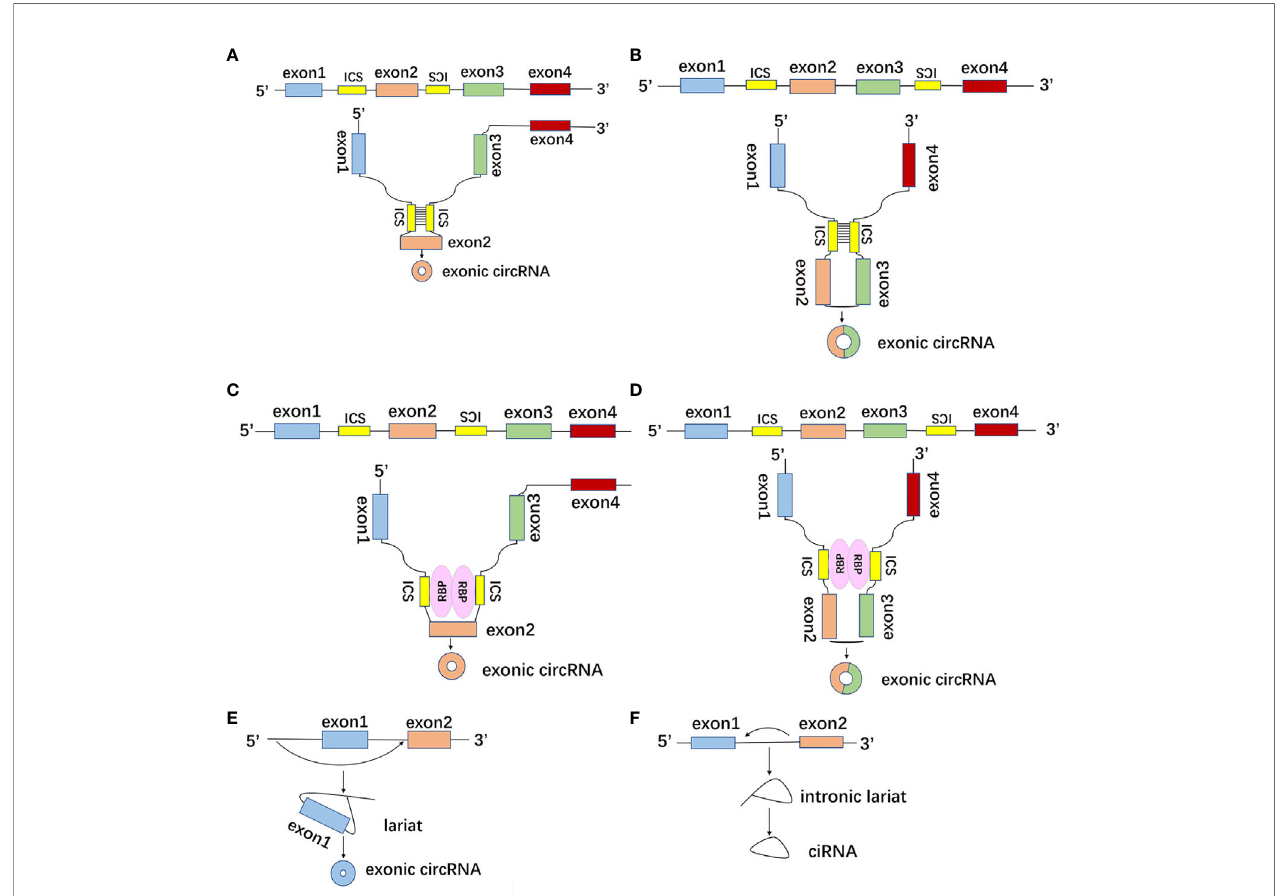
FIGURE 2 | The formation modes of circRNA. (A, B) CircRNAs with intronic complementary sequence (ICS) of pre-mRNA can make the distal intron splicing sites closer in space to promote reverse splicing and ICS pair-driven cyclization. (C, D) CircRNAs with double-stranded RNA binding domain (dsRBD) can bind and pair with ICS to make the splice site closer, as well as facilitate reverse splicing to increase circRNAs formation. (E) In the exon skipping event, the exon lariat formed by the covalently combined splice acceptor and splice donor provided by the exon. (F) Intronic lariat-driven cyclization was caused by intron removal during the pre- mRNA splicing